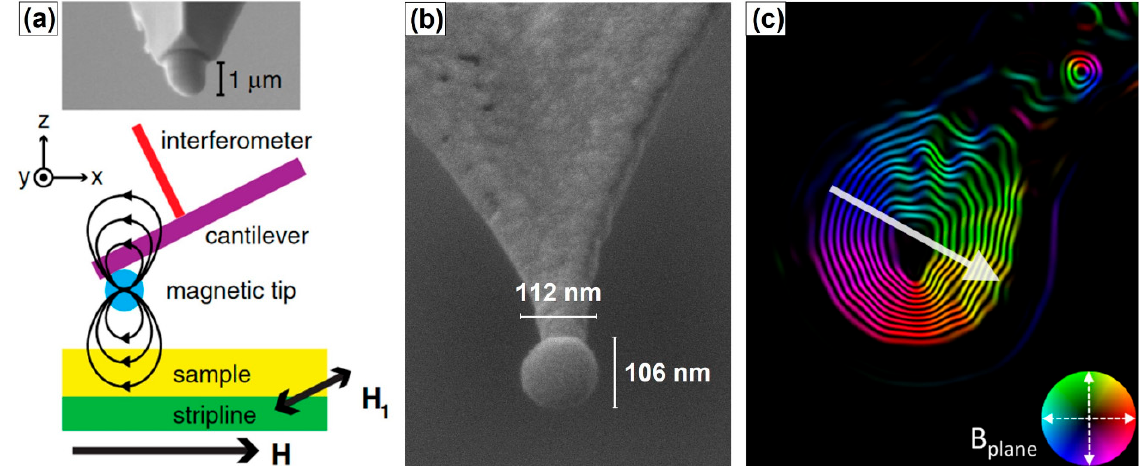
Figure 11. SEM images of ( a ) a 1.1 µm edge Co FEBID nanocube and ( b ) a 100 nm in diameter Co FEBID nanosphere used for MRFM. A sketch of the setup is illustrated in ( a ). ( c ) Magnetic induction flux map of the magnetic vortex state of the nanosphere. The inset shows the colour scale of the magnetic induction orientation. Adapted from [76,77].